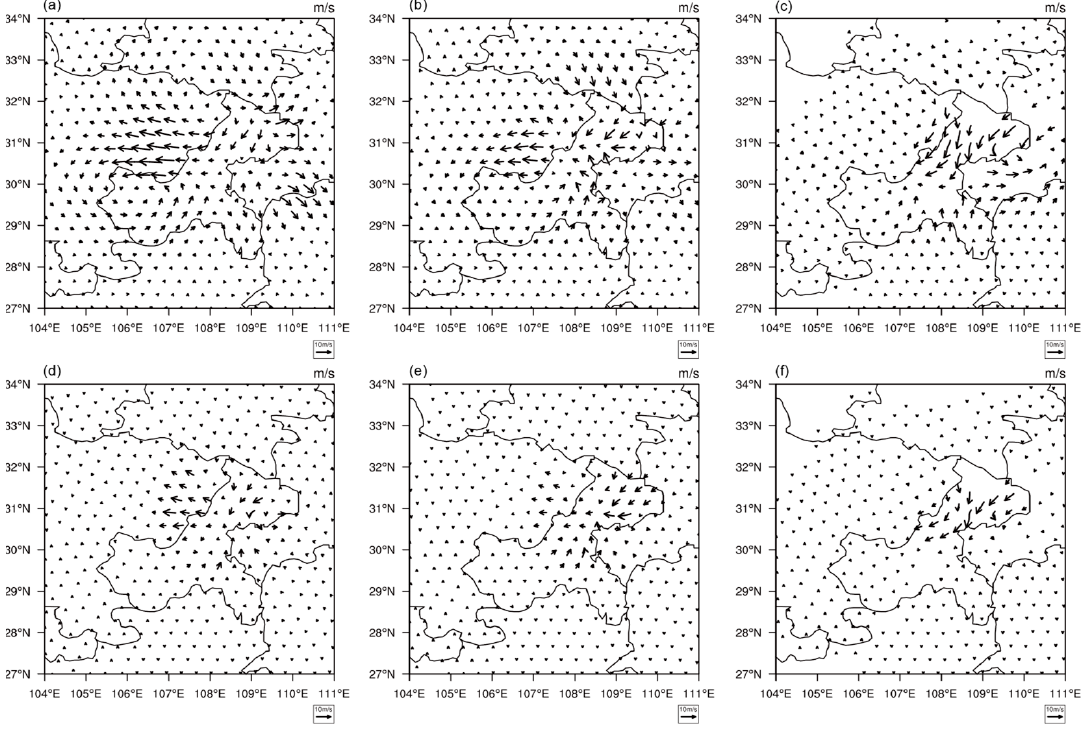
Figure 6. The increments of wind vector at 500 hPa, 700 hPa and 850 hPa after the assimilation of WZRD radial velocity and reflectivity using ( a–c ) the ψ−χ control variable and ( d–f ) U − V control variable. (Shaded; units: m s − 1 ).